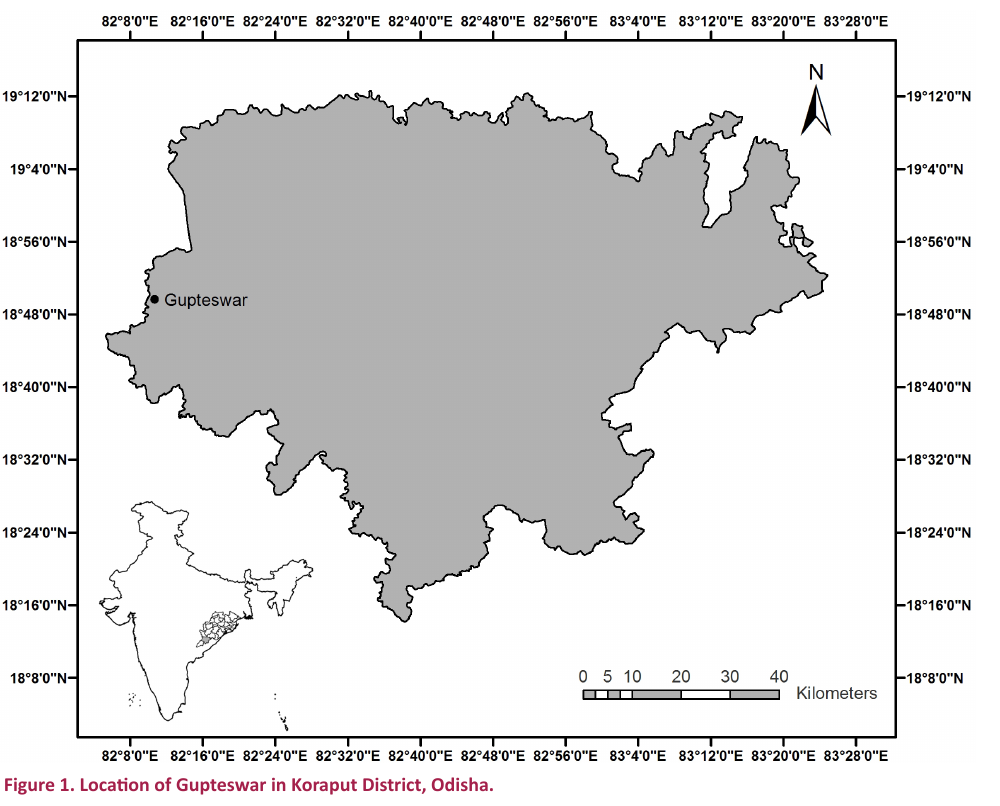
Black Baza. This is the first confirmed sighting and